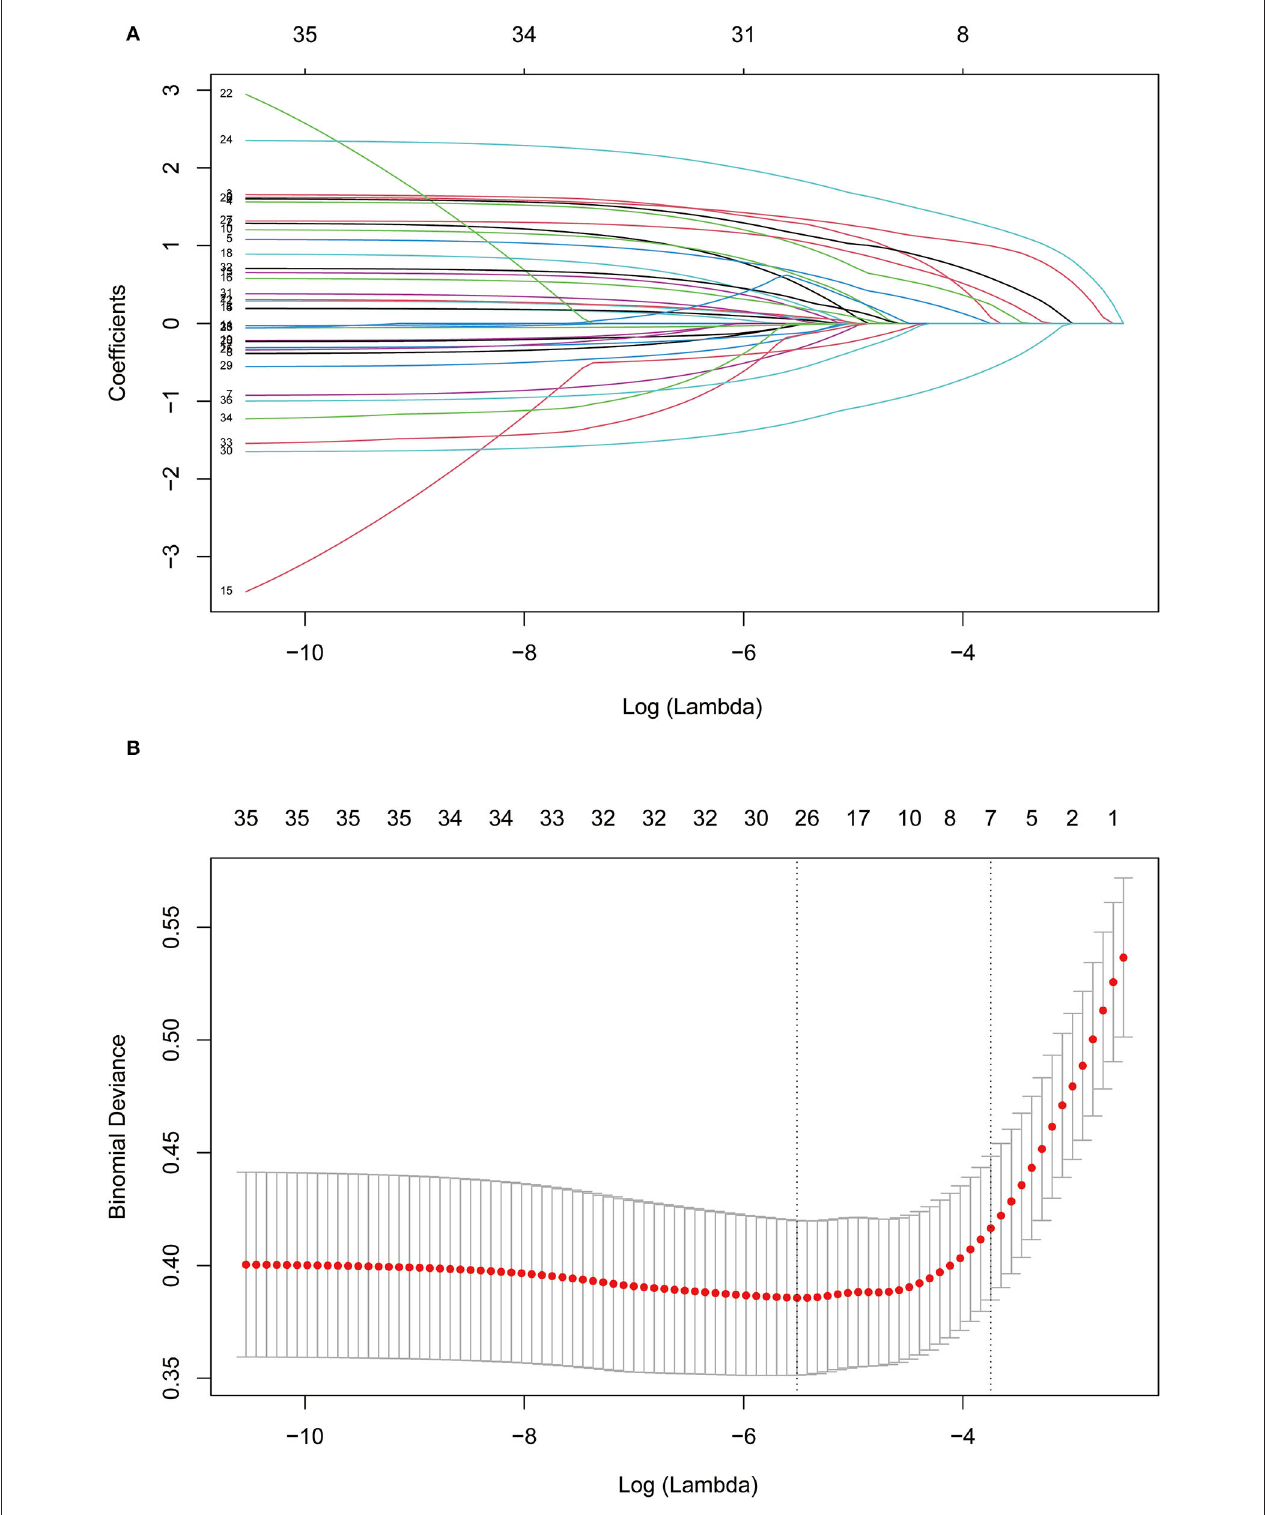
FIGURE 1 | Feature selection using Lasso regression. (A) Lasso coefficient profiles of the candidate features. (B) The selection of optimal parameters (lambda) by 10-fold cross-validation. The left and right dotted vertical lines, respectively, represented the optimal lambda values when using the minimum error criterion and one standard error (1-SE) of the minimum